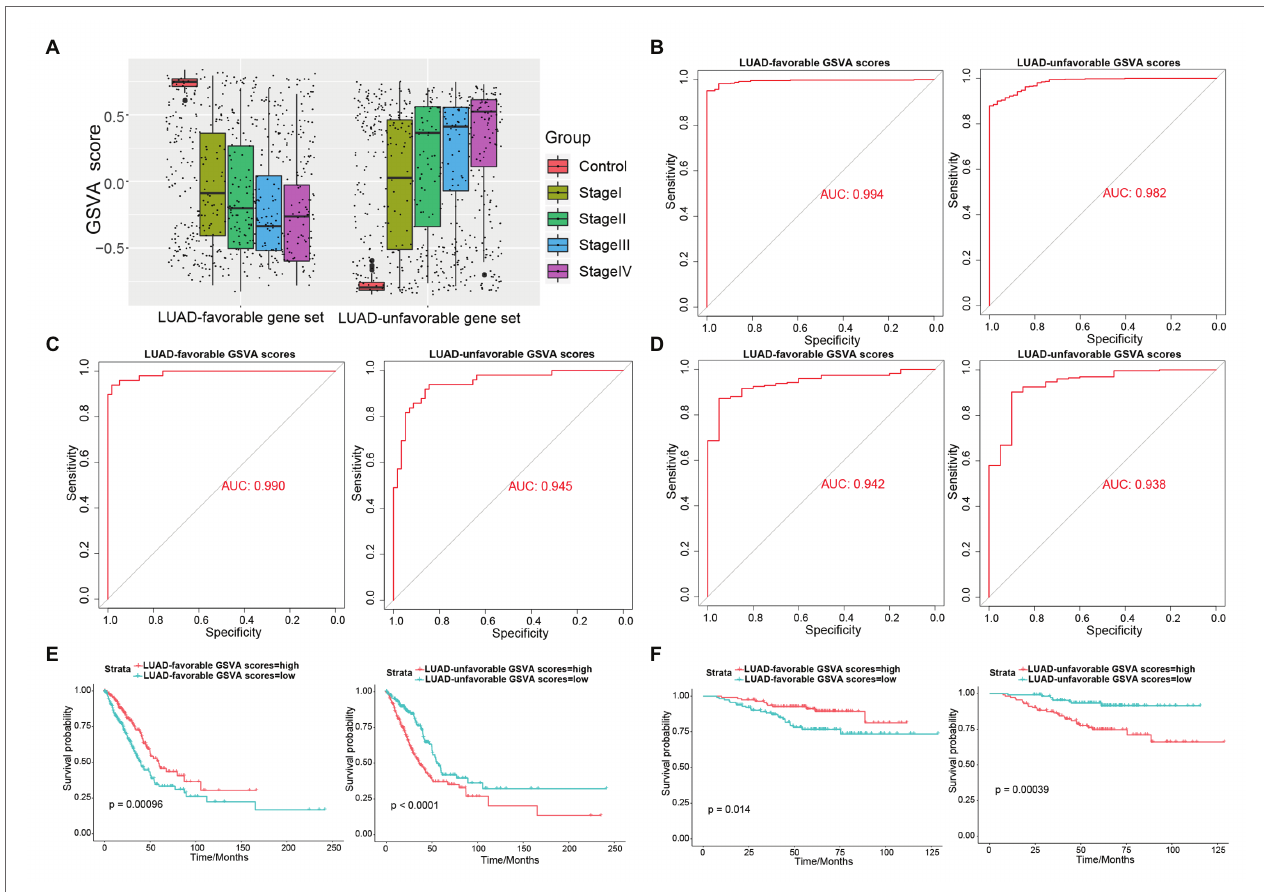
FIGURE 4 | Exploring the diagnostic and prognostic abilities of LUAD-unfavorable gene set and LUAD-favorable gene set. (A) The box plots of LUAD-unfavorable gene set gene set variation analysis (GSVA) score and LUAD-favorable gene set GSVA score. (B) Receiver operating characteristic (ROC) curves analysis of LUAD-unfavorable gene set GSVA score and LUAD-favorable gene set GSVA score. (C) ROC curves analysis of LUAD-unfavorable GSVA score and LUAD-favorable GSVA score in GSE10072. (D) ROC curves analysis of LUAD-unfavorable GSVA score and LUAD-favorable GSVA score in GSE31210. (E) Survival analysis of LUAD-unfavorable gene set GSVA score and LUAD-favorable gene set GSVA score in LUAD from The Cancer Genome Atlas (TCGA). (F) Survival analysis of LUAD-unfavorable GSVA score and LUAD-favorable GSVA score in GSE31210.